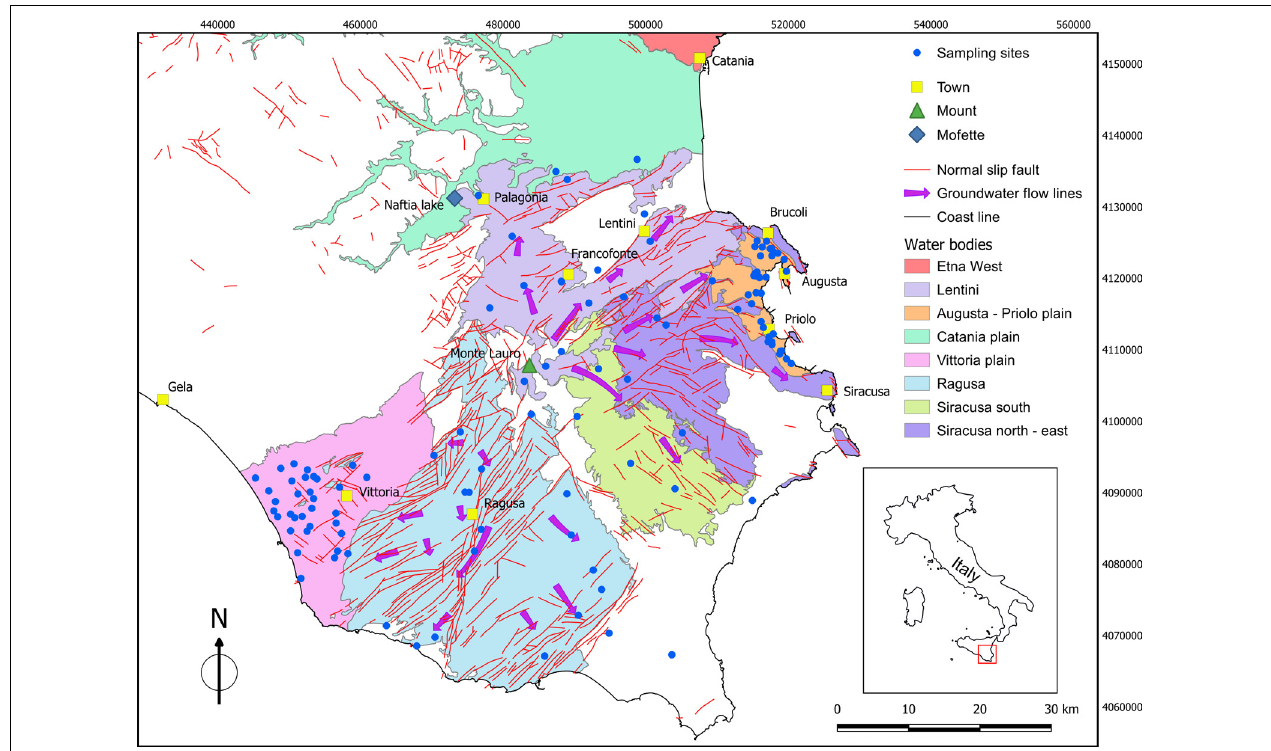
FIGURE 1 | Hydrological settings of the Hyblean area. Sampling sites are indicated by open circles. See legend for explanation of colors and symbols in the map. The square box in the figure delimits the area used in Figures 7A–D . Coordinates are in UTM